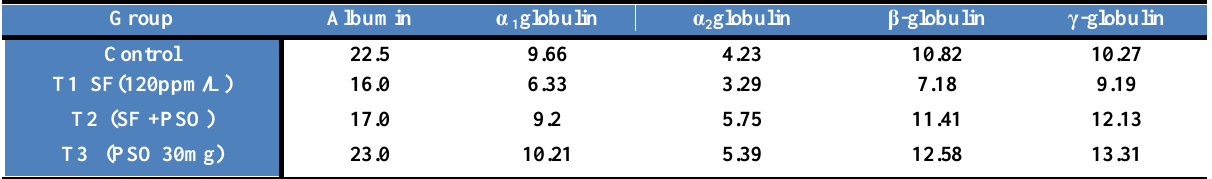
Table, 4: Effect of pomegranate seed oil (PSO) and sodium fluoride (SF) o n serum proteins electrophoresis (protein fraction %) in female rats.